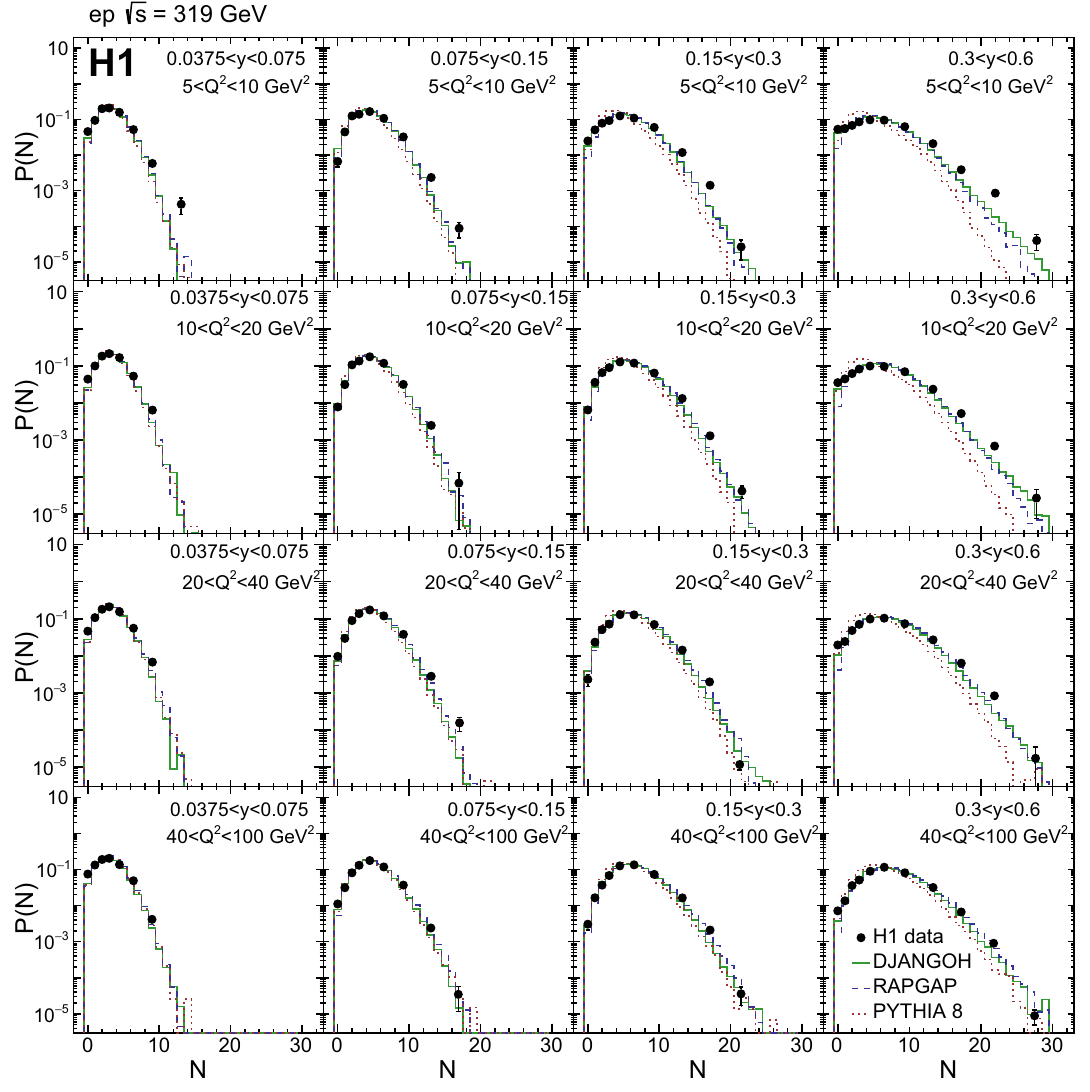
Fig. 2 Charged particle multiplicity distributions P ( N ) as a function in the figure. The phase space restrictions are given in Table 1. Predic- √ s = 319GeV ep collisions. Different of the number of particles N at tions from DJANGOH, RAPGAP and PYTHIA 8 are also shown. The panels correspond to different Q 2 and y bins, as indicated by the text total uncertainty is denoted by the error